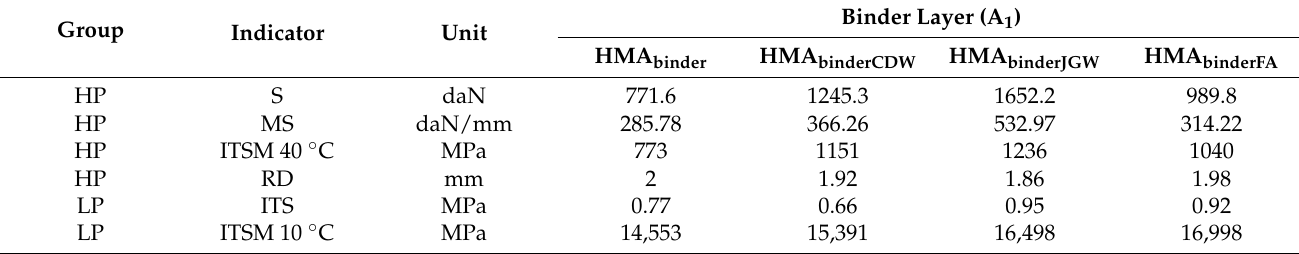
Table 3. Mechanical characteristics and LCA parameters reported as the decision matrixes A 1 for binder layer adopted for